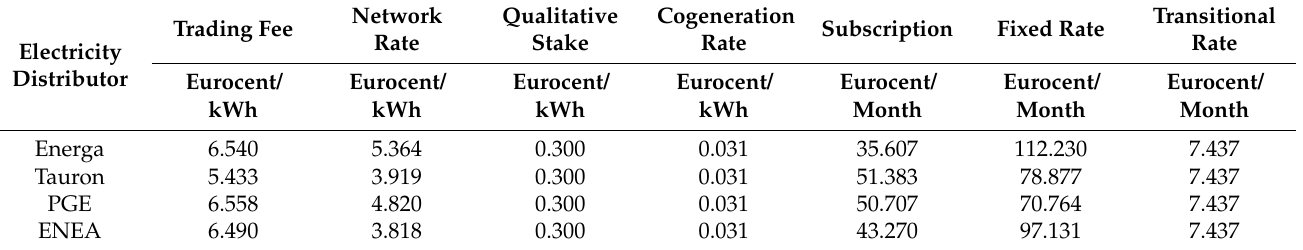
Table 1. A table of fees for